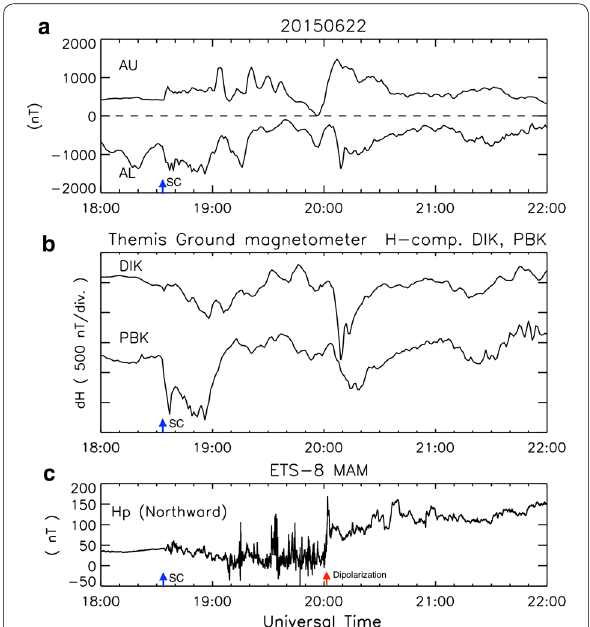
Fig. 8 a The auroral electrojet indices (AU and AL) and b magnetic H-components at Dixon (DIK, 02 MLT at 20 UT) and Pebek (PBK, 07 MLT). c The Hp (northward) component of the magnetic field measured onboard the geosynchronous orbit satellite, ETS-VIII. The westward AEJ increases at 2005 UT after the magnetic dipolarization in the magnetotail at 2001